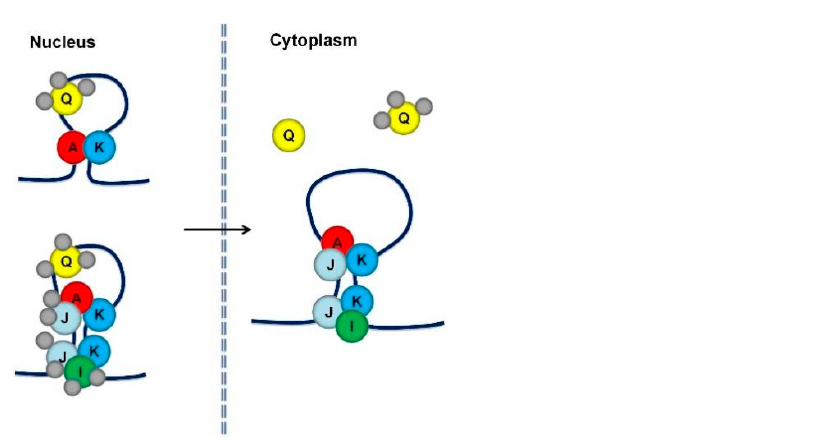
Figure 4. A proposed working model of five RBPs involved in prolamine mRNA localization (adapted from [37]). Five RBPs, A, I, J, K, and Q assemble into at least three different RBP complexes that recognize and bind to prolamine zipcodes. RBPs A, I, J and K form two cytoplasmic complexes, A-J-K and I-J-K. These two RBP complexes together with a third complex containing RBP-Q may also be present in the nucleus. In the nucleus, RBPs I and J may be associated with other proteins preventing their recognition by antibodies. When associated with RBP-A and RBP-K, RBP-Q is not accessible to its antibody, suggesting that it is bound by other proteins that comprise a third multiprotein family. Alternatively, the nucleus contains a simpler complex consisting of RBPs A and K as well as the RBP-Q complex.